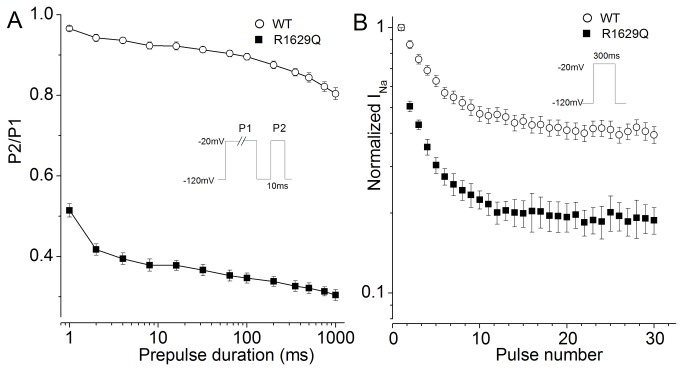
R1629Q enhances Nav1.5 channel into intermediate inactivation.(A) Time dependence of intermediate inactivation for WT and R1629Q.The two-pulse protocol is shown in the Inset. Differences between WT (open circle, n=9) and R1629Q (filled squre, n=8) were significant at all prepulse durations from 1 to 1000ms. (B)Activity-dependent loss of sodium channel availability. Sodium currents are recorded during series trains of 300ms depolarization to -20mV from holding potential -120mV.Currents are normalized to the value obtained after the first pulse and plotted against the successive pulse number. The residual normalized current level recorded after 30th pulse is 39.4%±2.1% for WT (open circles, n=14) and 18.7%±2.1% for R1629Q (filled squares, n=15) (P<0.01).